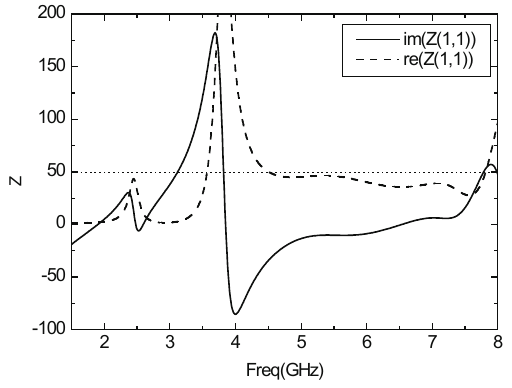
Figure 11. Input impedance curve of the